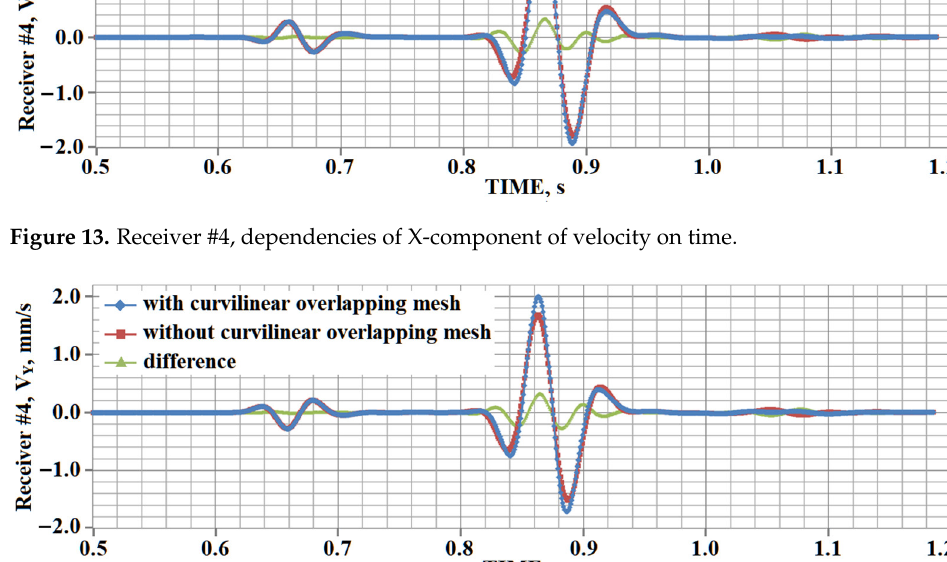
Figure 14. Receiver #4, dependencies of Y-component of velocity on time. The data on the plots in Figures 12–20 are registered by the receivers marked by red color in Figure 8 and correspond to vertical lines on the seismograms in Figures 9–11.